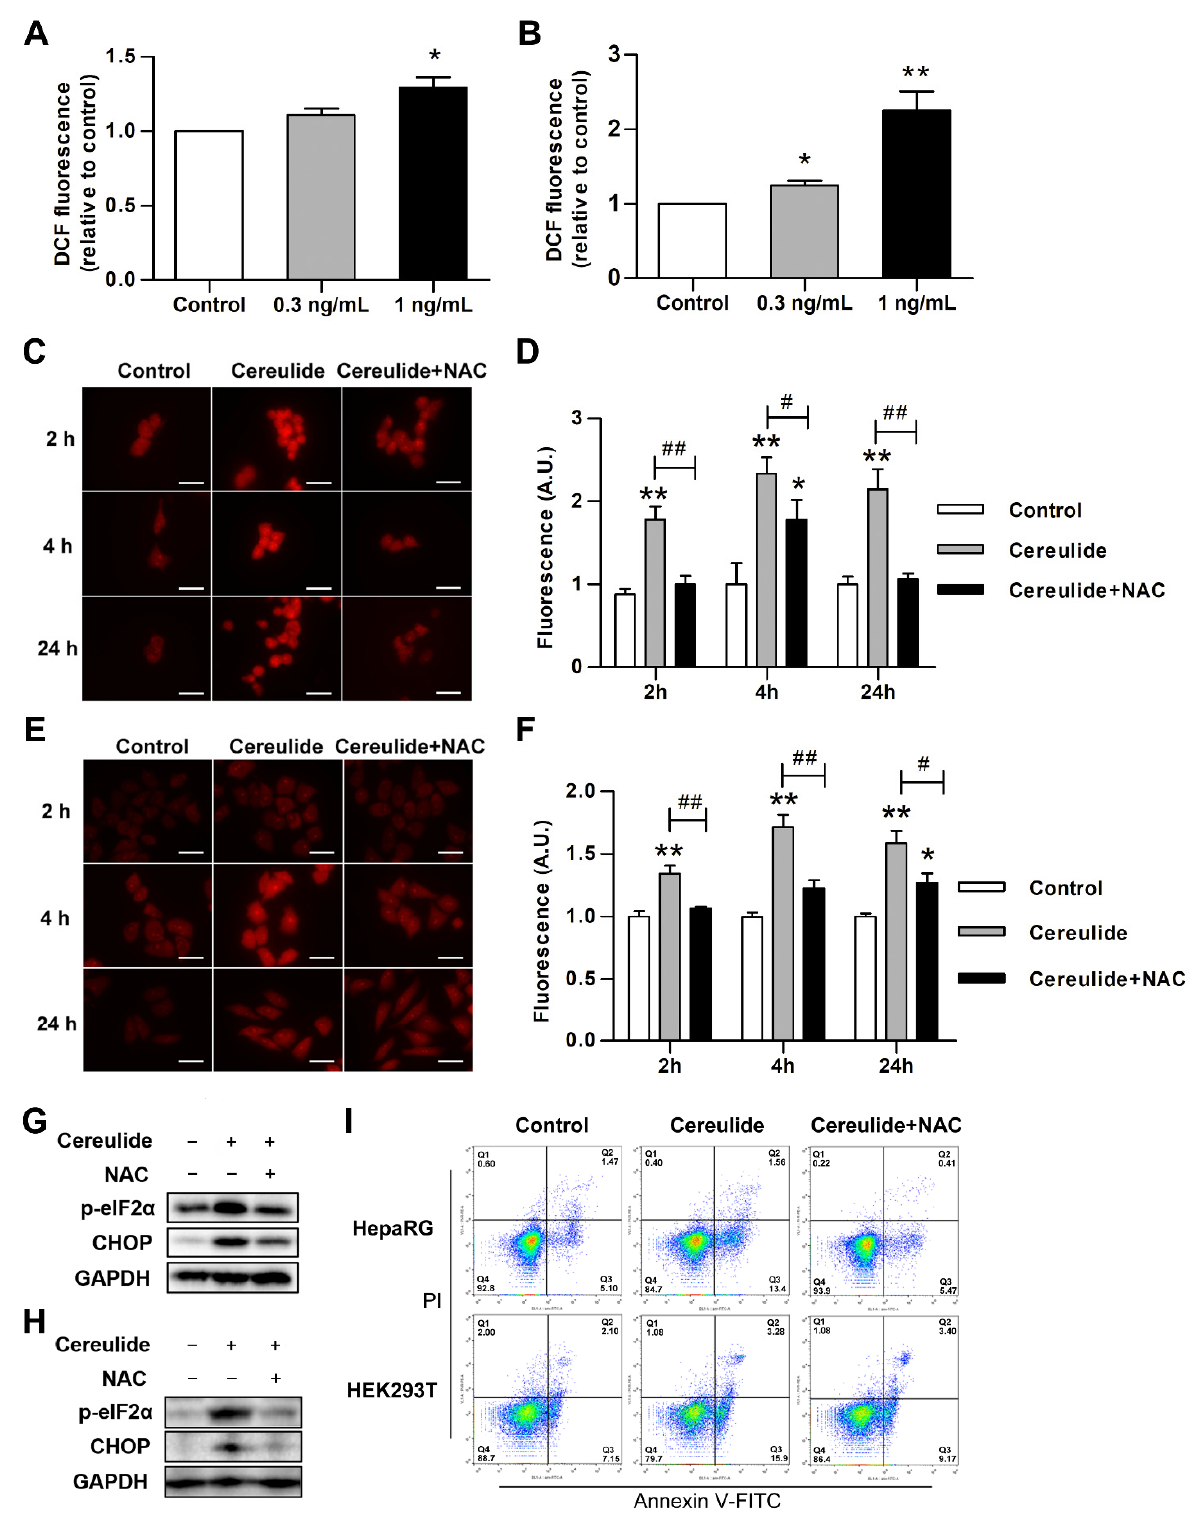
Figure 4. Cereulide induces ER Stress response by ROS production. ( A , B ) Cereulide causes an increase in ROS production. HepaRG and HEK293T cells were treated with 0, 0.3, 1 ng/mL cereulide for 24 h, the fluorescence of dichlorofluorescindiacetate (DCF) were detected at 488 nm excitation and 525 nm emission; n = 5. ( C , D ) Effects of ROS inhibitor on ROS production after cereulide treatment. HEK293T cells were pretreated with 5 mM NAC followed by treatment of 0.5 ng/mL cereulide for 2, 4, 24 h. Cytosolic ROS production measured by DHE labeling, n = 5. ( E , F ) HepaRG cells were pretreated with 7 mM NAC followed by treatment of 1 ng/mL cereulide for 2, 4, 24 h; n = 5. For C and E panels, image